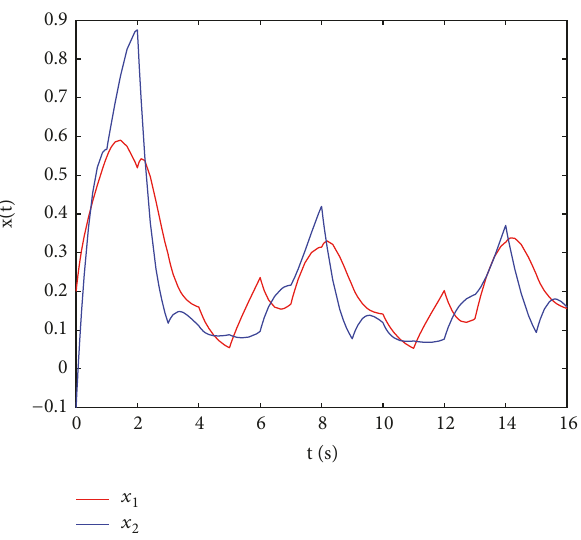
Figure 4: The state trajectories of system (1) with 𝜏(𝑡) = 0.5 + 0.5 sin 𝑡